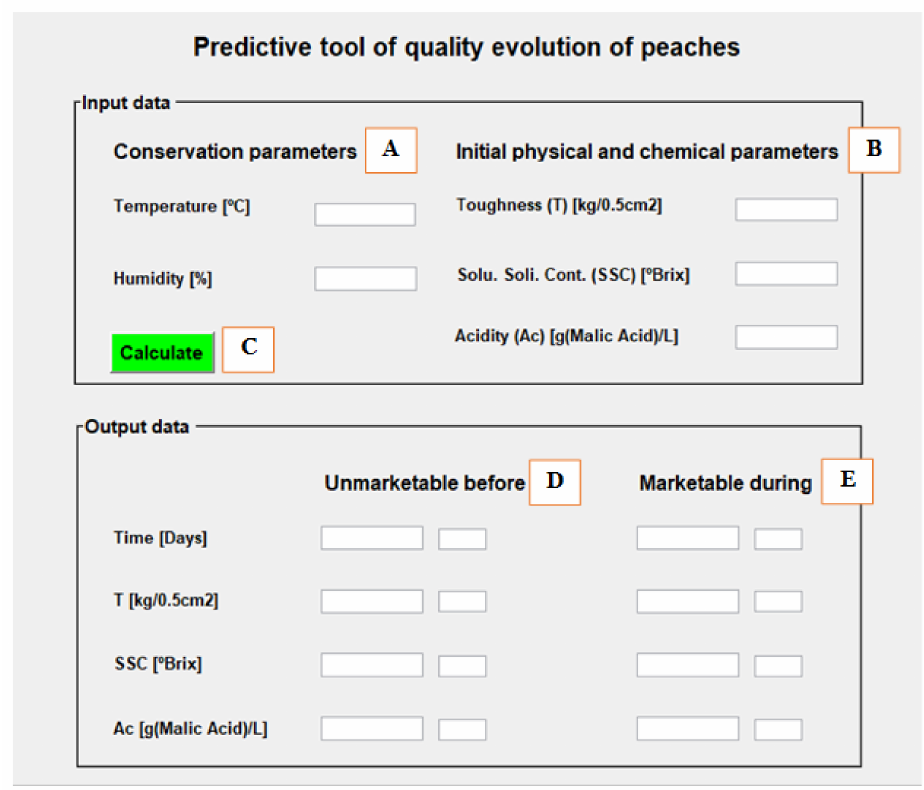
Figure 5. User interface of the ANN decision support system.